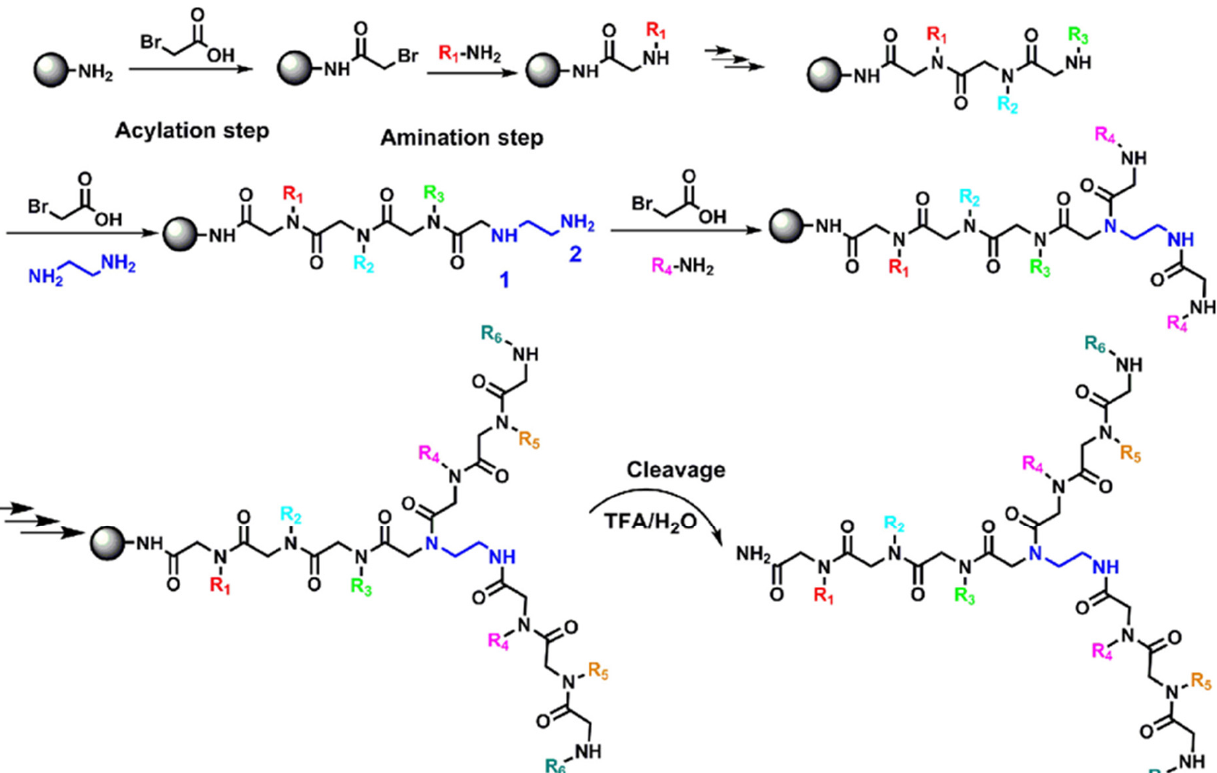
Figure 5. A facile solid-phase synthesis of three-armed star-shaped peptoids (Adapted from ref. [35]. Copyright 2019, Wiley Periodicals, Inc.).